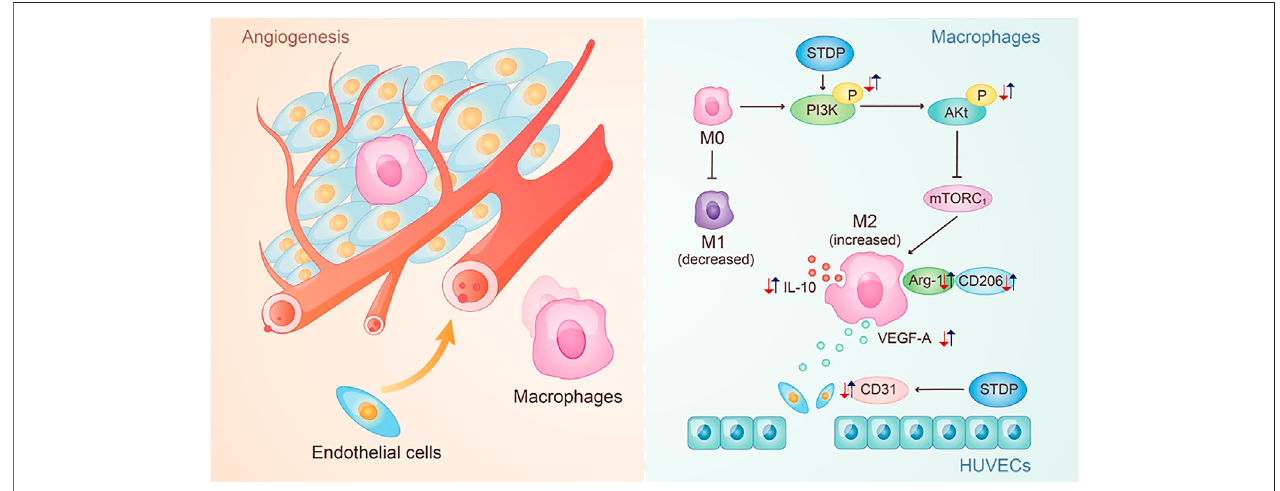
FIGURE7| PotentialmechanismofSTDPsonCMD.Theredarrowsrepresentthechangetrendofkeyfactorsinthepathologicalenvironment,andthebluearrows represent the change trend of key factors after the STDPs administration.